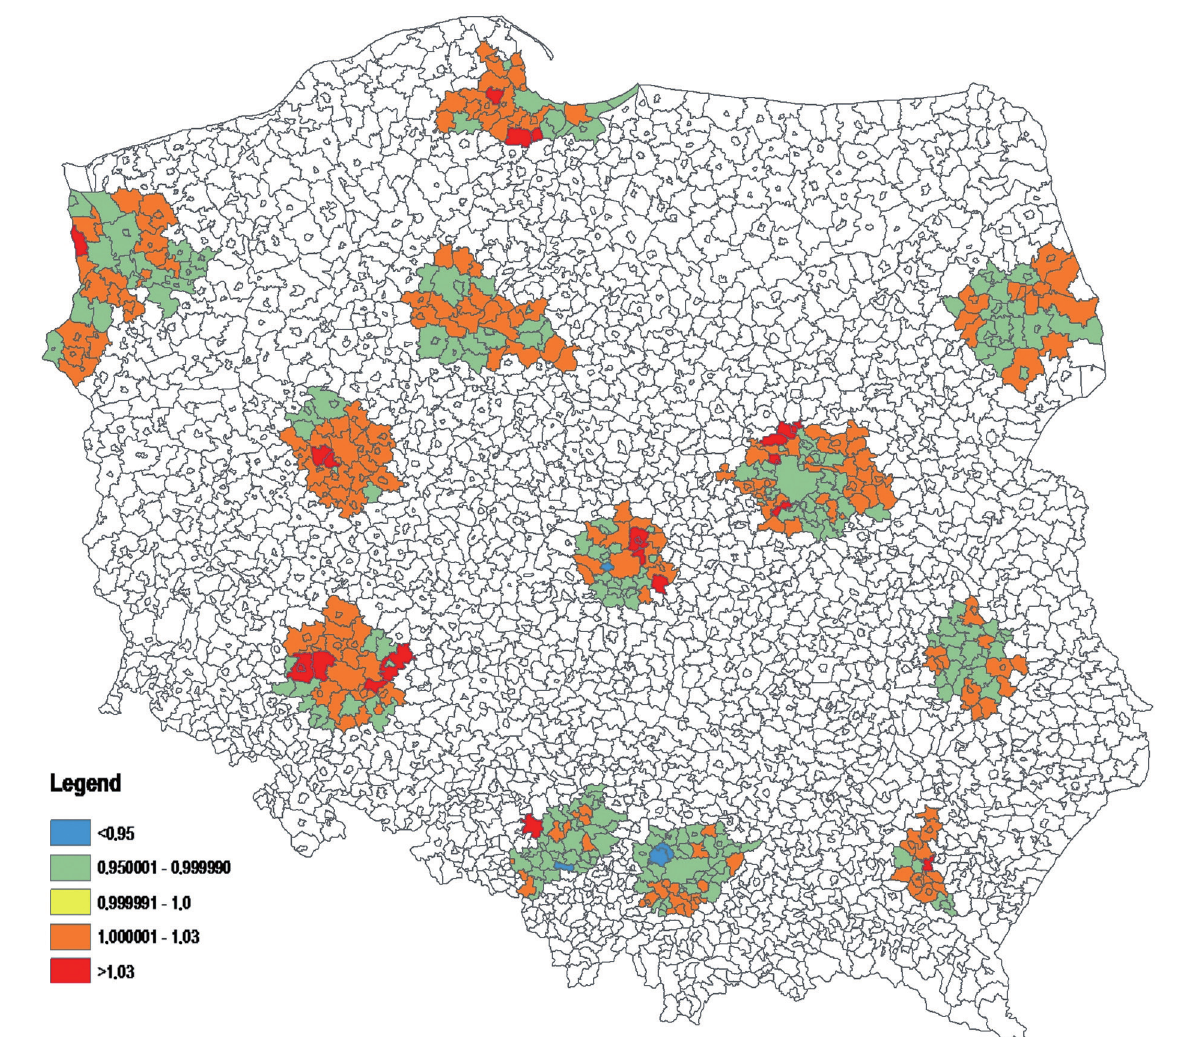
Fig. 5. Dynamics of entropy of the land use structure in municipalities of the metropolitan areas of Poland (2006/2000, see explanation in